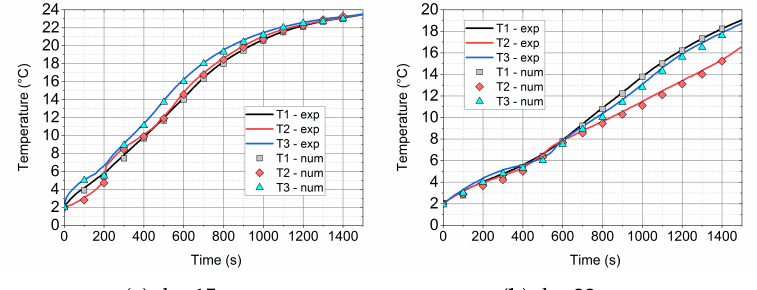
Figure 14. Comparison of the experimental and numerical results for the inlet velocity of 0.92 m/s and different cylinder di- ameters.